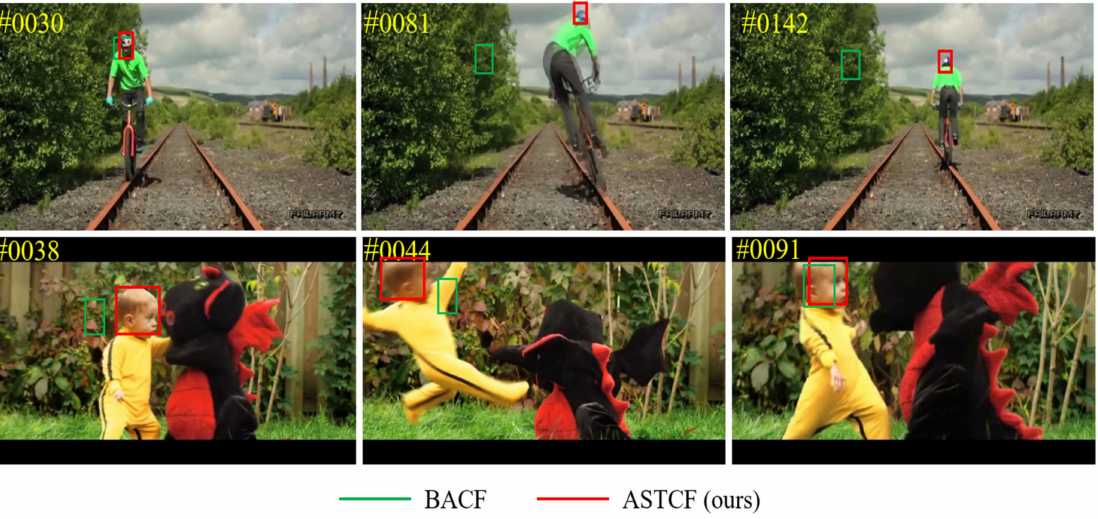
Figure 1. The tracking results of ASTCF and BACF on two video sequences with motion blur and